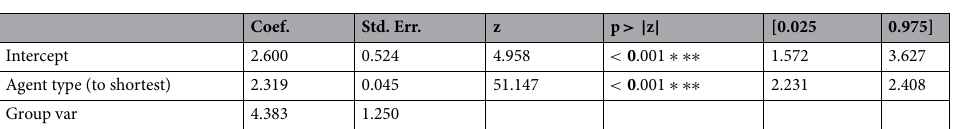
Table 4. Results of the ‘ Difference in Time to Escalator ’ Mixed linear model regression, diffTime ∼ AgentType + ( 1 | AgentID ) , we denote p-values satisfying the Bonferroni corrected alpha with ***.